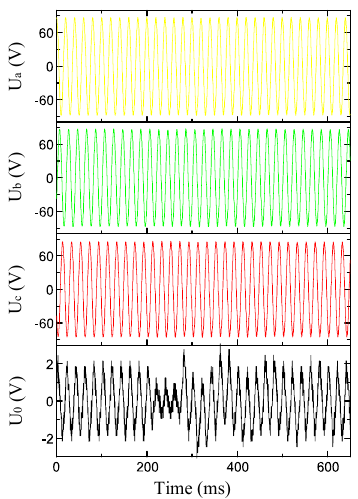
Figure 18. Voltage waveform before and after KM action.